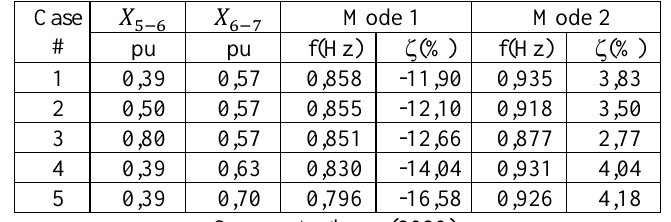
Figure 3: Equivalent Brazilian system configuration. Table 1: Operating